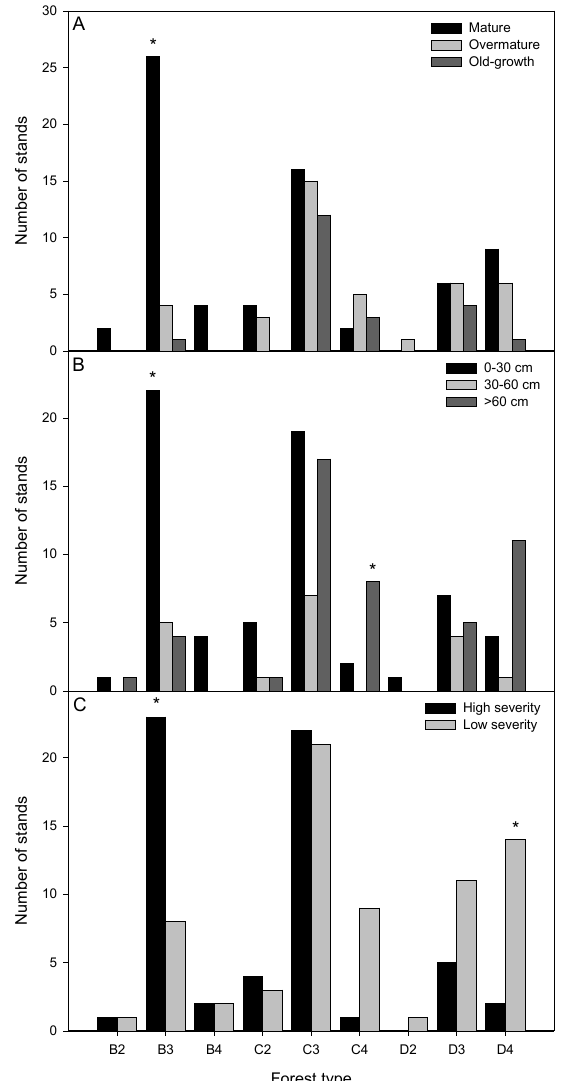
Figure 2. Frequency distribution of levels of variables representing target processes among different forest types. Time since fire ( A ); organic layer thickness ( B ); fire severity ( C ). Forest types where the distribution differs from the expected ( i.e ., an equal distribution among classes within a variable) are indicated by an